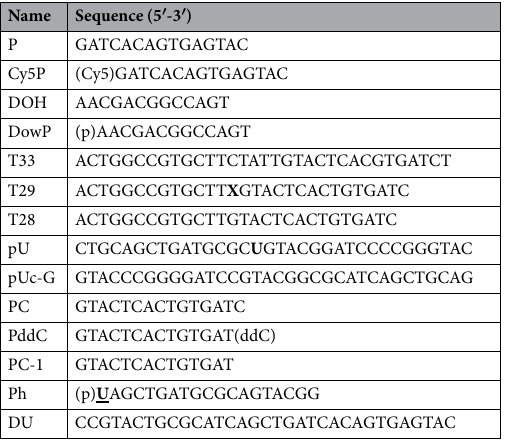
Table 1. Oligonucleotides used in this study. U denotes 2 ′ -deoxyuridine. Cy5 stands for 1,1 ′